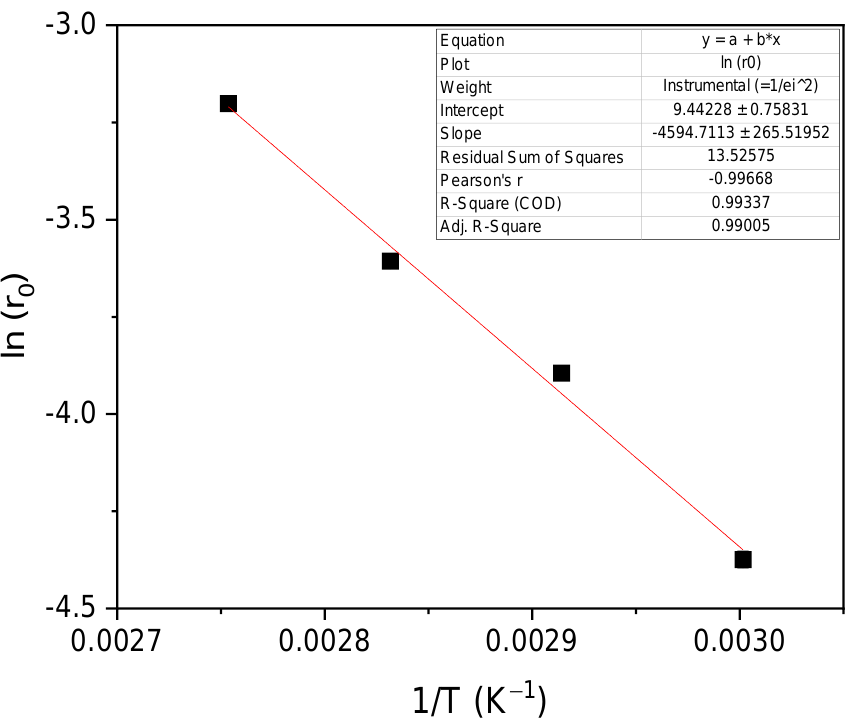
Figure 6. Dependence of the initial reaction rate with temperature (Arrhenius plot).